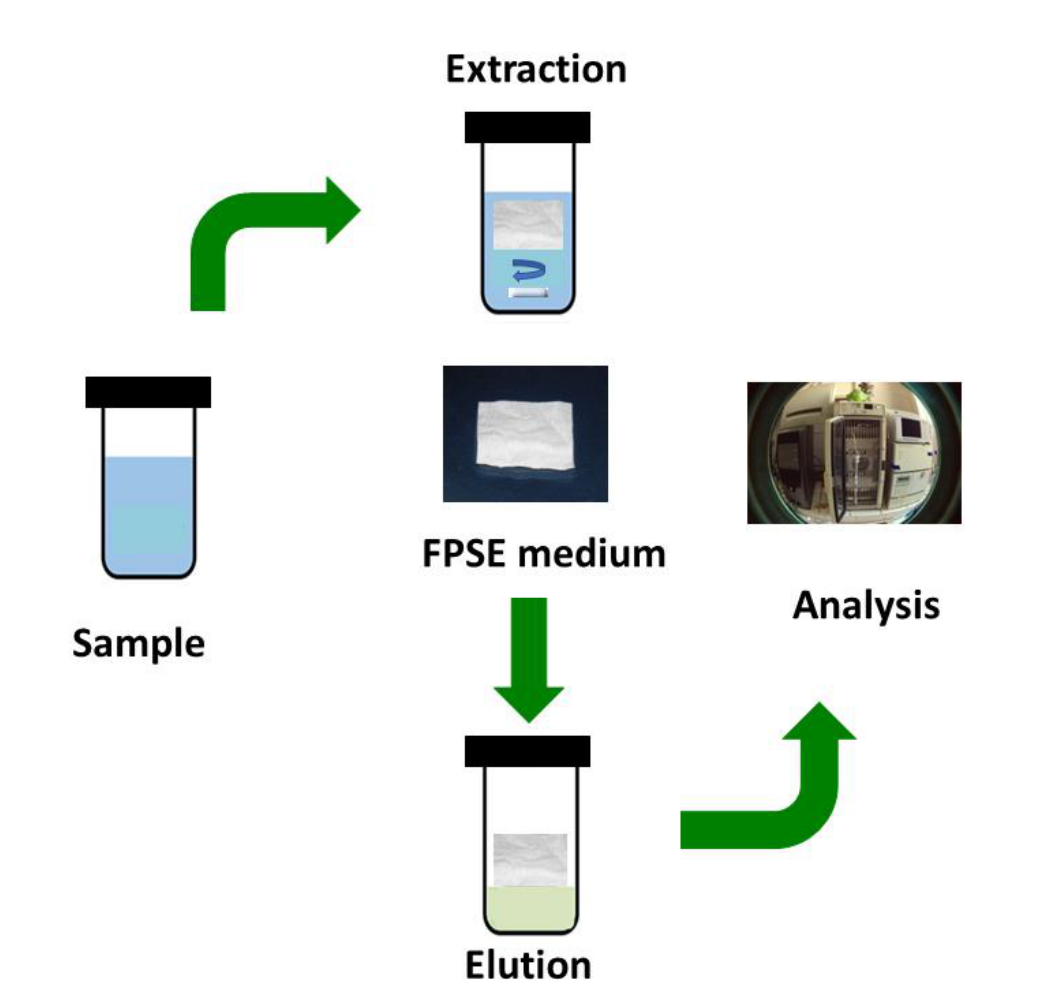
Figure 1. Typical FPSE workflow.